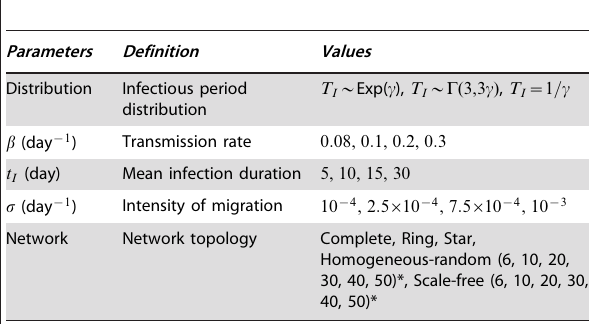
Table 2. Values taken by input factors in